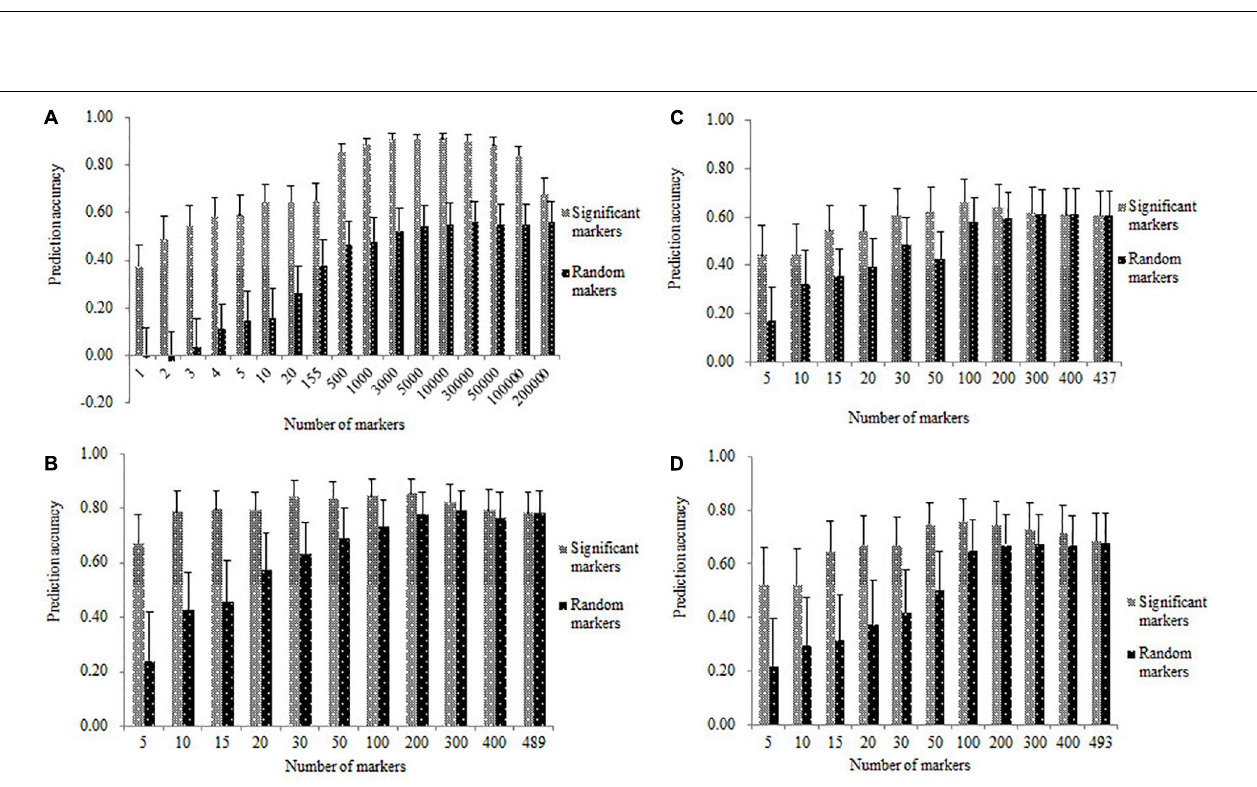
FIGURE 5 | Genomic prediction accuracies for TSC resistance estimated with the same number of significant and random markers in all the four populations of (A) DTMA association mapping panel, (B) Pop1, (C) Pop2, and (D) Pop3.